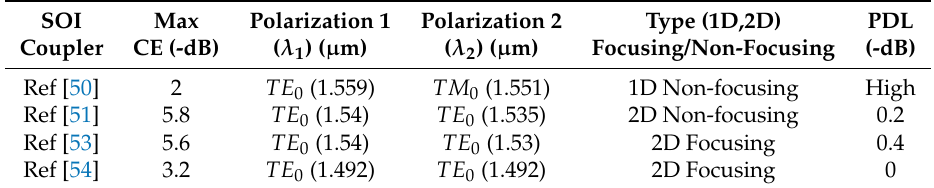
Table 3. Performance comparison of various SOI based polarization splitting grating couplers (PSGCs). Columns 3 and 4 pertain to the polarization state of the coupled waveguide modes. PDL denotes the minimum polarization dependent